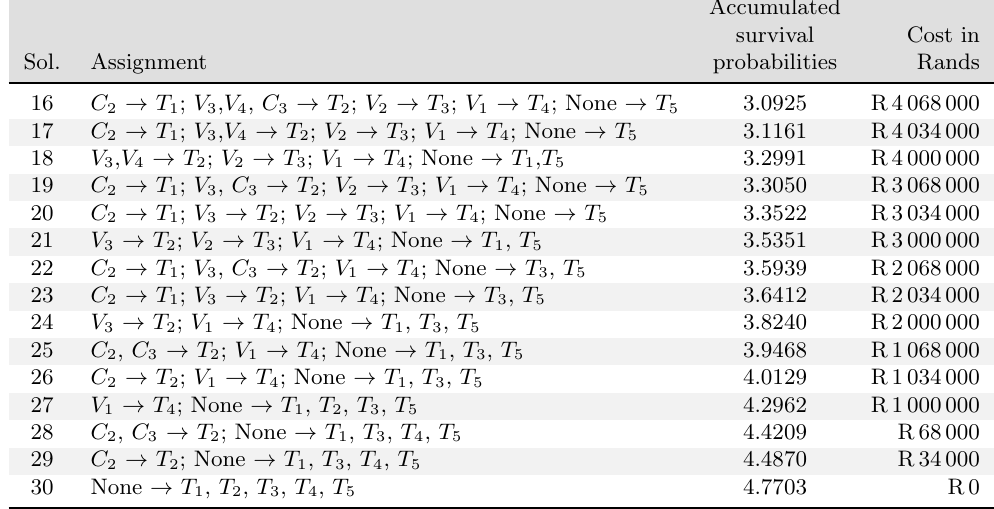
Table 6: The set of approximately Pareto optimal solutions obtained by the NSGA II for stage t 35 of the scenario, using the same solution indices as in Figure 4.